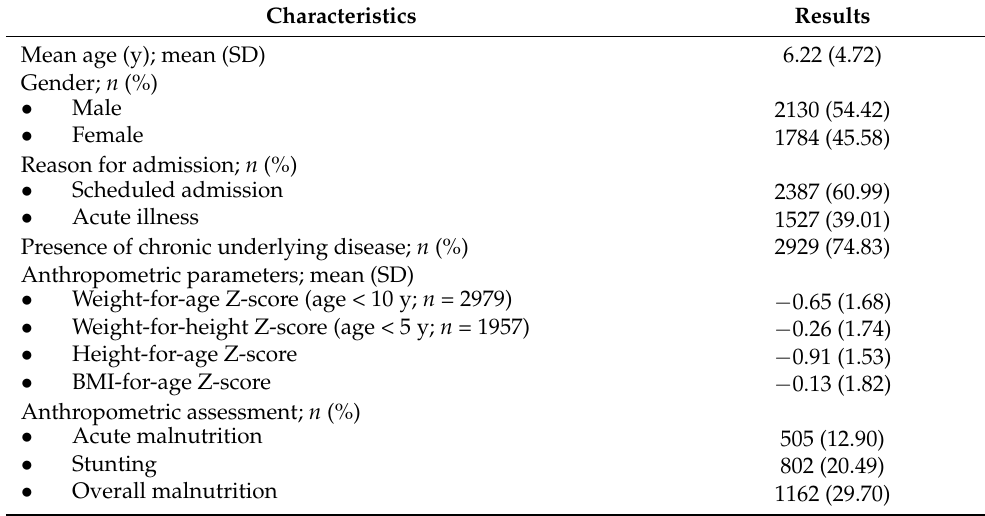
Figure 1. Study enrollment of electronic medical records. Table 1. Baseline characteristics and anthropometric data of 3914 electronic medical records.